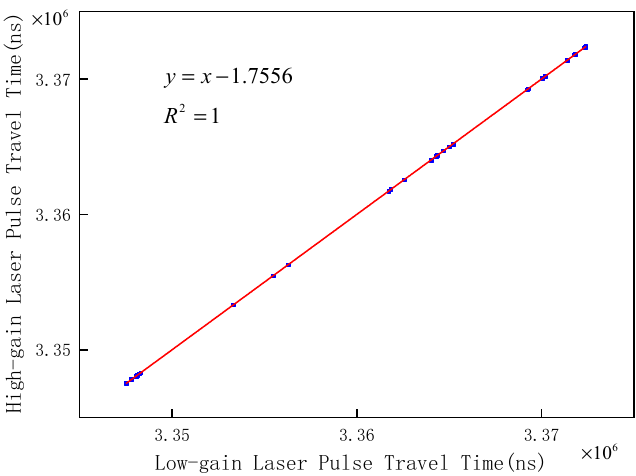
Figure 10. Fitting results of the high- and low-gain time of flight.